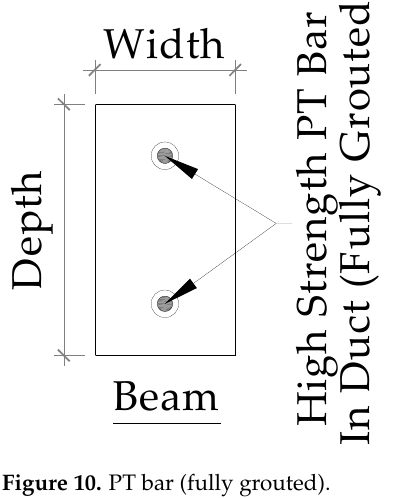
Figure 10. PT bar (fully grouted).